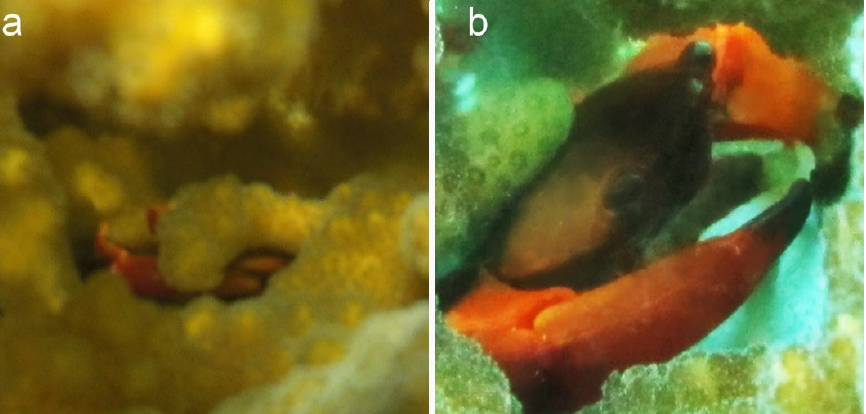
Figure 3. Recruitment of Trapezia in Pocillopora fragments. ( a ) Trapezia sp. hidden between coral branches; ( b ) Close up to Trapezia crab.